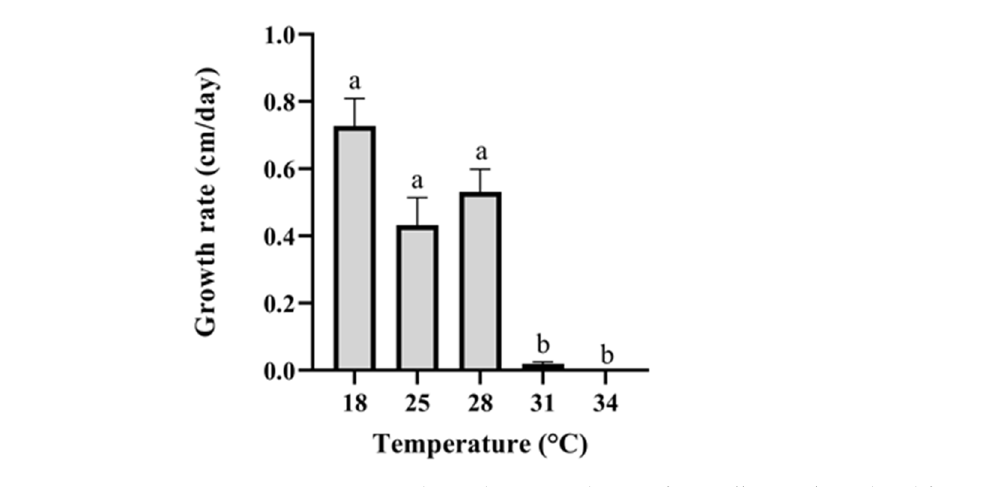
Figure 8. Temperature-dependent growth rate of Penicillium stekii isolated from mesophotic Agelas oroides . Bars indicate standard error. Different letters above the columns designate the values presented are significantly different ( p ≤ 0.05).